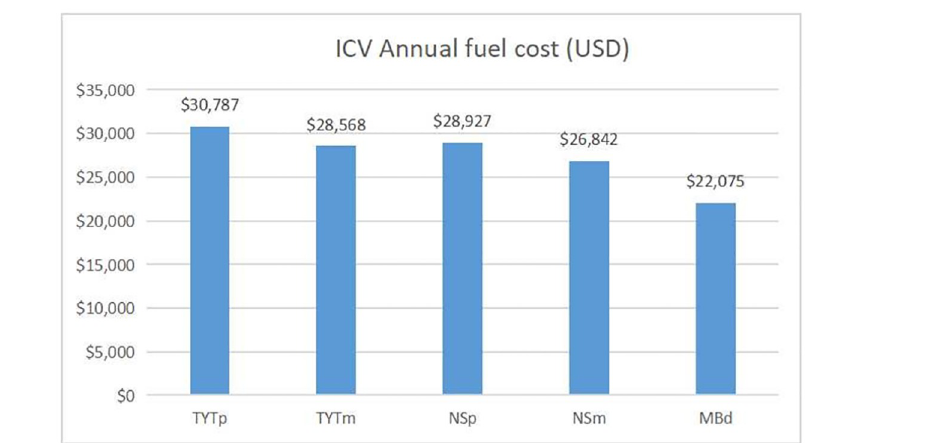
Fig 5. Annual fuel cost per vehicle, Morelia and